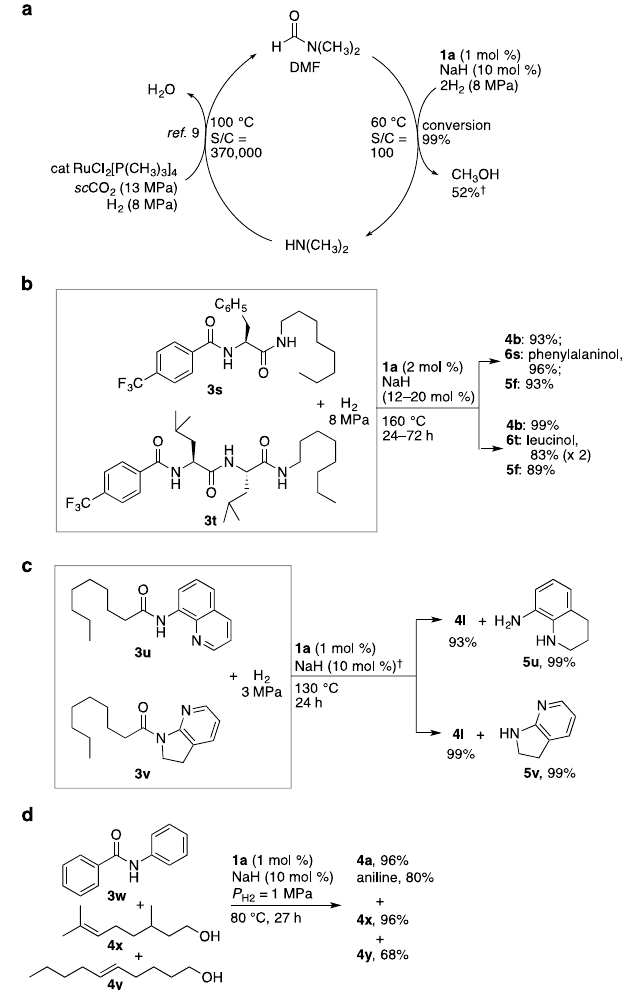
Figure 5. Multifaceted features of hydrogenation of small and highly functionalized amides. ( a ) DMF hydrogenation ( b ), Oligoamide hydrogenation. ( c ) Hydrogenation of 3u and 3v bearing directing